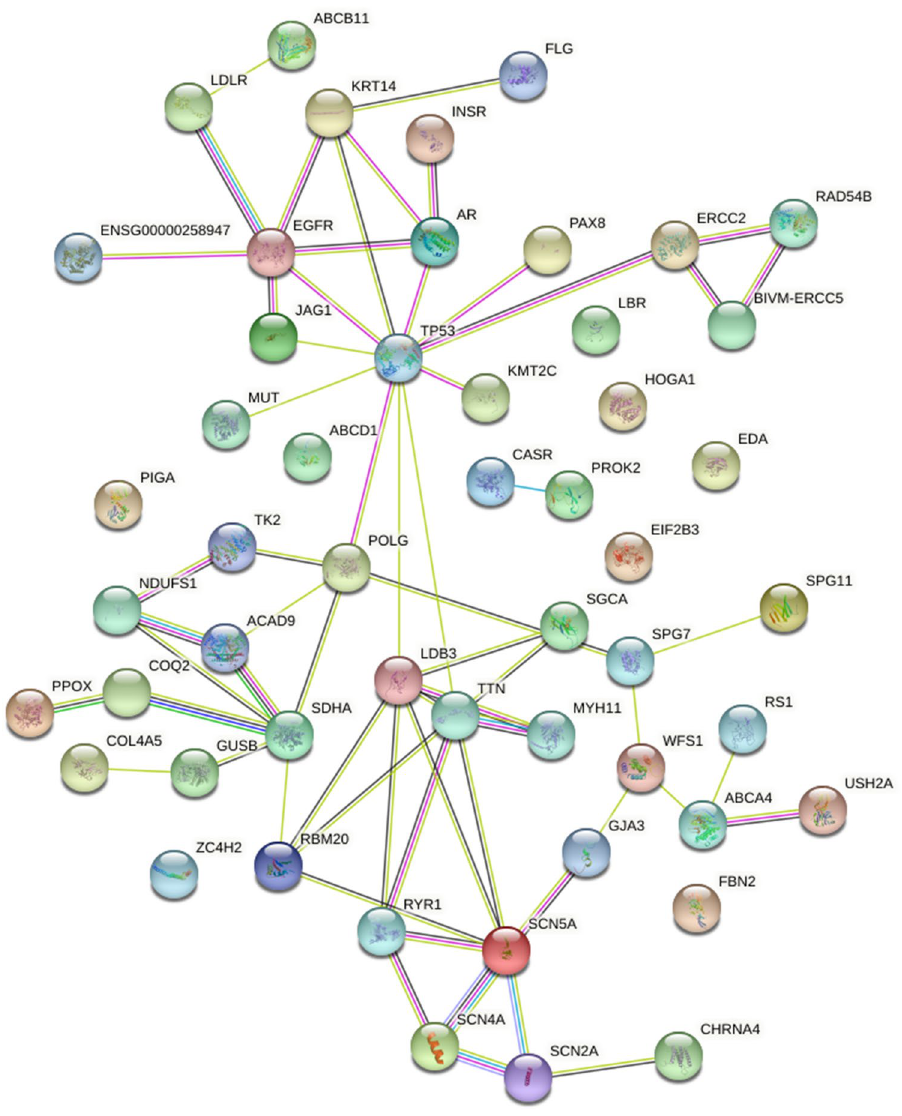
Figure 3. PPI network of 53 driver genes.